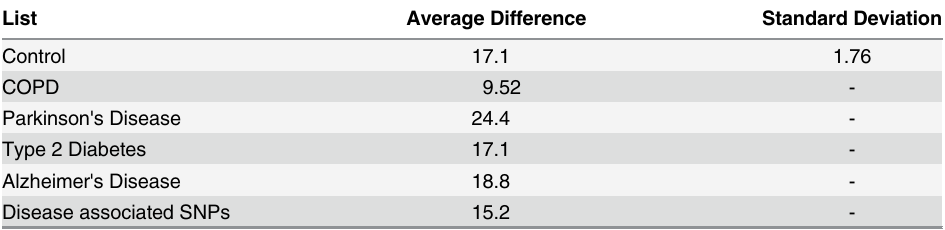
Table 2. In COPD the difference between the average GC content of the transcription start site and the first acceptor splice site is significantly smaller than expected (p = 0.004).